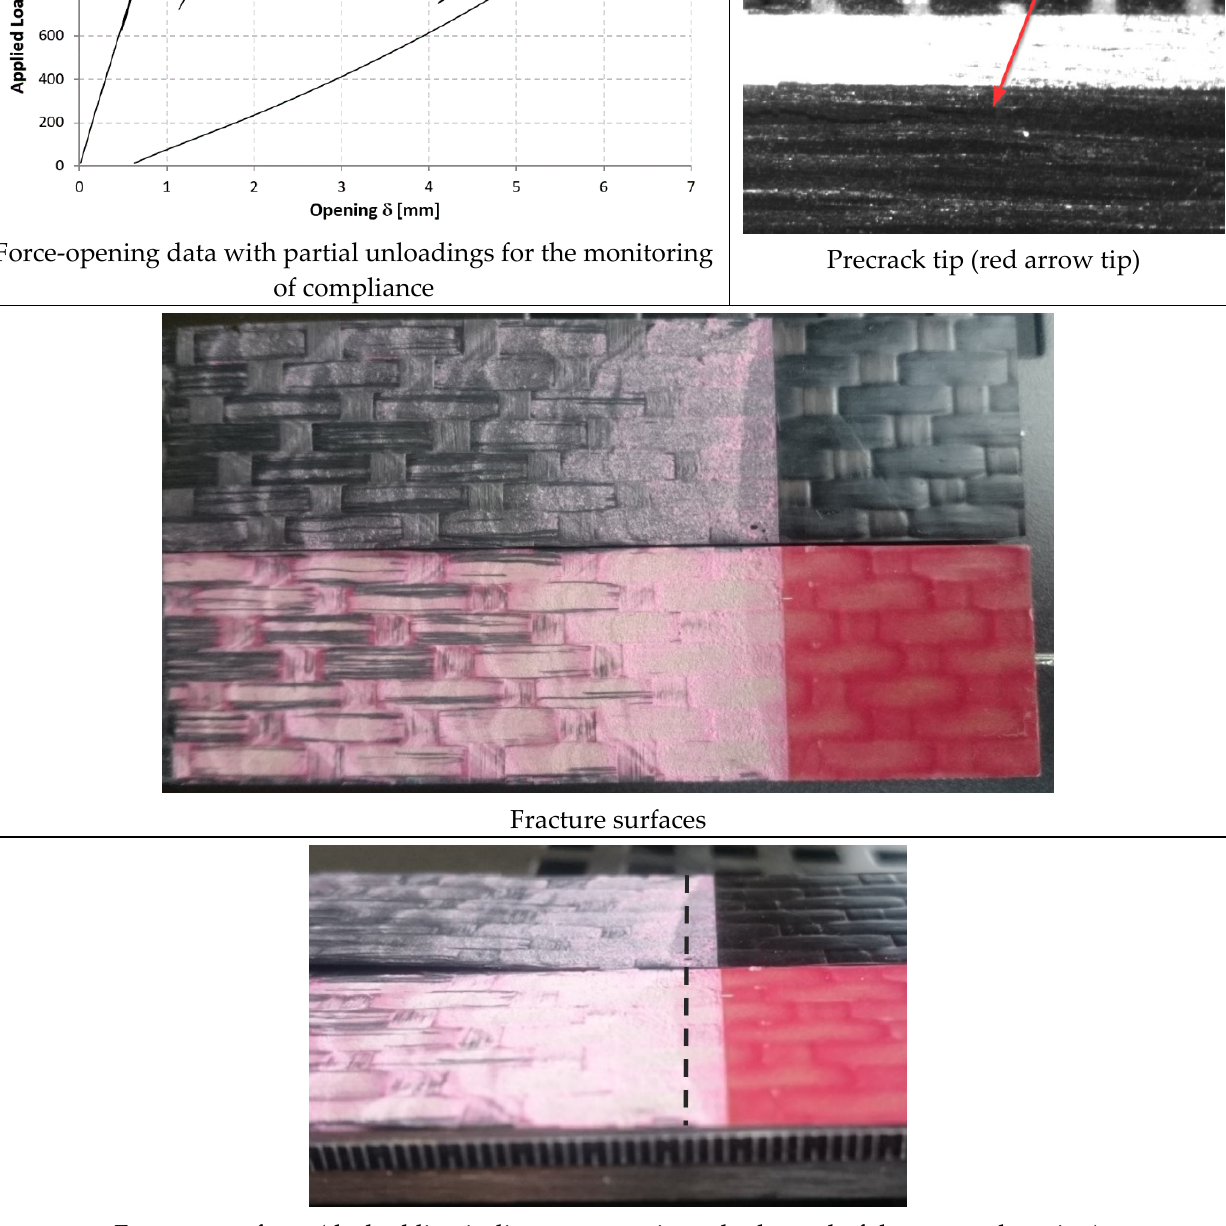
Figure 16. Results of the test on specimen DCB_AF163_03.